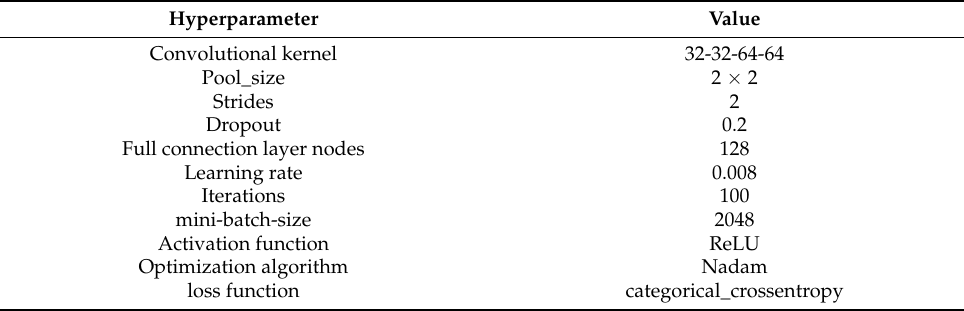
Table 4. Hyperparameters of convolutional neural network